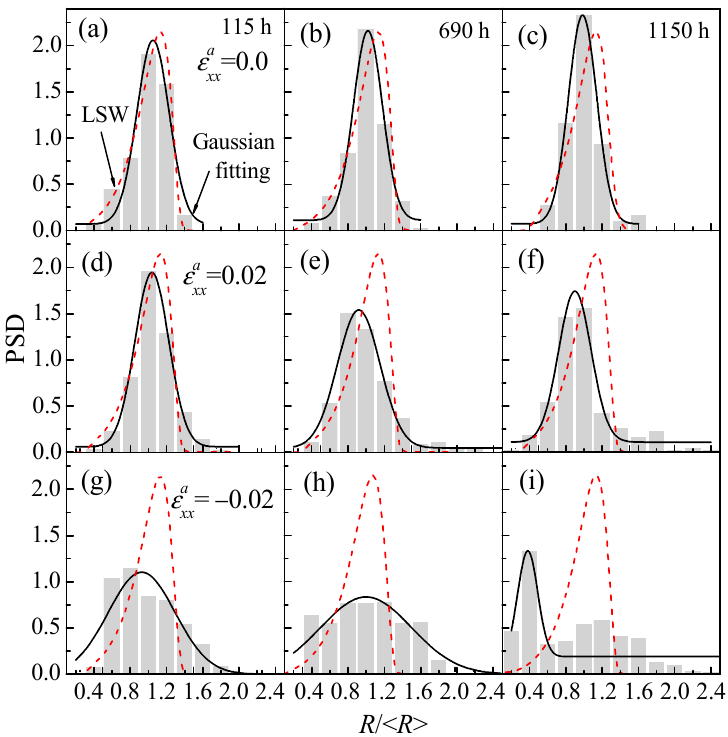
Figure 6. The histogram of the particle size distribution (PSD) of the α (cid:48) phase in Fe-28 at.% Cr alloy as a function of aging time aged at 750 K, ( a – c ) ε a xx = 0.0, ( d – f ) ε a xx = 0.02, ( g – i ) ε a xx = − 0.02. ( a , d , g ) 115 h, ( b , e , h ) 690 h, ( c , f , i ) 1150